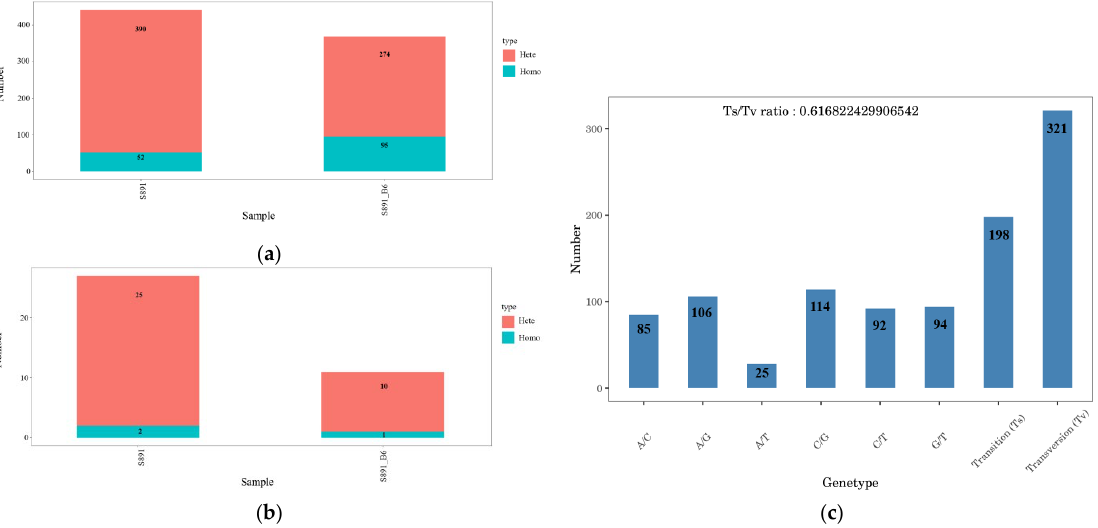
Figure 5. The DEGs of comparative transcriptomic analysis between strains 891 and 891-B6: ( a ) GO; ( b ) KEGG.